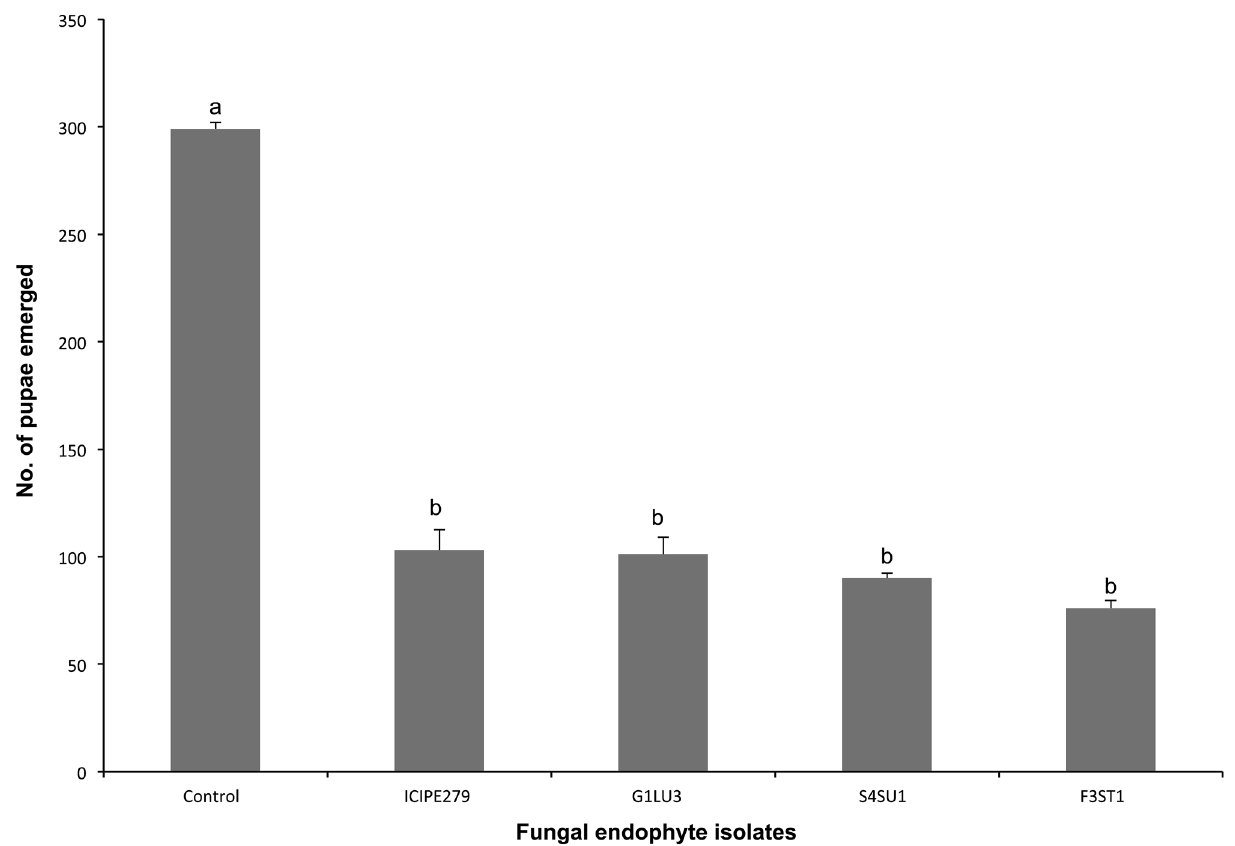
Figure 6. Effect of Viciafaba plants endophytically-colonized by different fungal isolates of Beauveriabassiana (S4SU1, G1LU3 and ICIPE279) and Hypocrealixii (F3ST1) on adult emergence of Liriomyzahuidobrensis and Phaedrotomascabriventris . Bars denote means 6 one standard error at 95% CI (p=0.05).